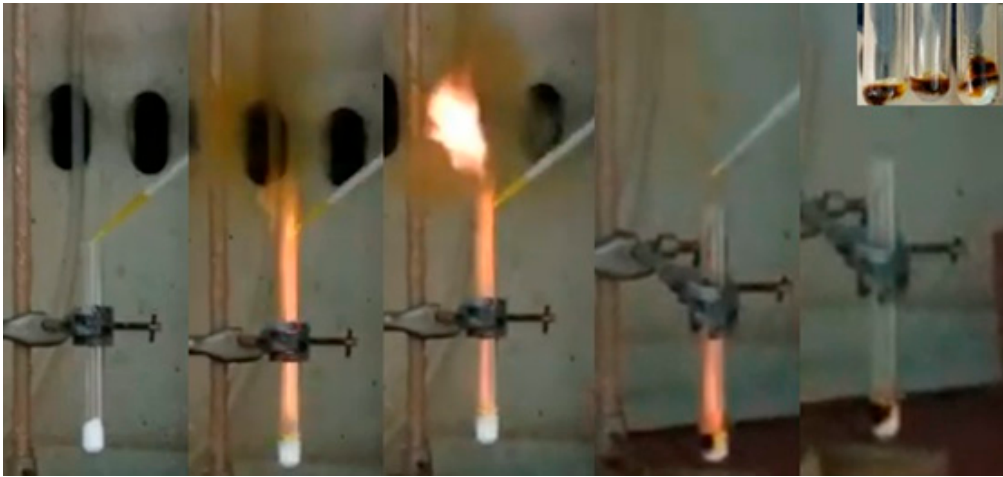
Figure 2. Dropwise addition of fuming nitric acid into Girard’s reagent T ignites the hydrazide derivative , thus resulting in a water-soluble brown residue on the walls of the test tube (see